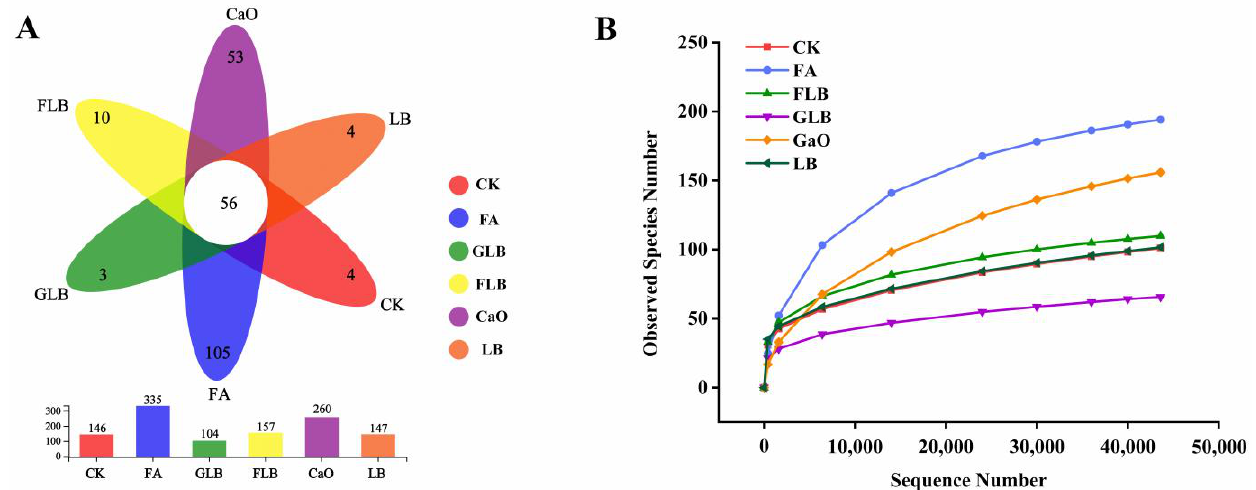
Figure 1. Petal plots illustrating the extent of overlapping bacteriological operational taxonomic units (OTUs) in the six treatments. Each petal denotes a treatment, the number in the middle represents the OTUs common to all treatments, and the number on the petal represents the OTUs specific to that treatment. The bar plots present the total bacteriological OTUs in six treatments ( A ). Observed rarefaction curves for species indices. The horizontal coordinate is the number of sequencing strips selected randomly from a sample, and the vertical coordinate is the number of OTUs that could be constructed on the basis of the number of sequencing strips to reflect the sequencing depth. Different treatments are represented by different colors ( B ). CK, control, no additive; FA, 0.6% formic acid; CaO, 3% calcium oxide and 3% urea; LB, 1 × 10 6 cfu/g L. buchneri ; GLB, 2% glucose and 1 × 10 6 cfu/g L. buchneri ; FLB, 2% fucoidan and 1 × 10 6 cfu/g L. buchneri .